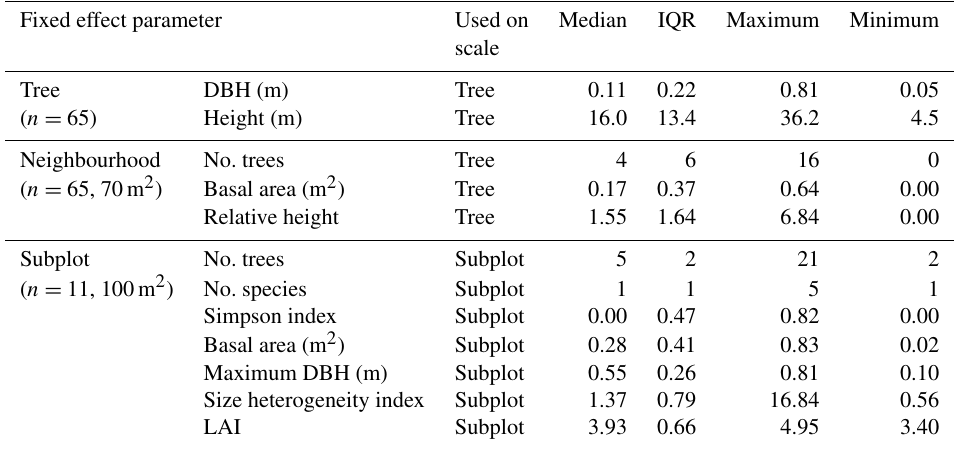
Table 1. Distributed parameters of tree, neighbourhood and subplot properties used as fixed effects in the linear mixed effects models of the named scale.